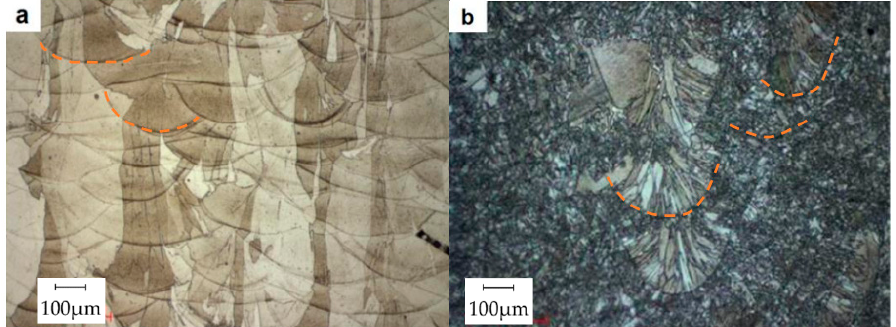
Figure 14. ( a , b ) OM cross-section observation of two 17-4 PH samples obtained from L-PBF, starting from different powder batches [136].